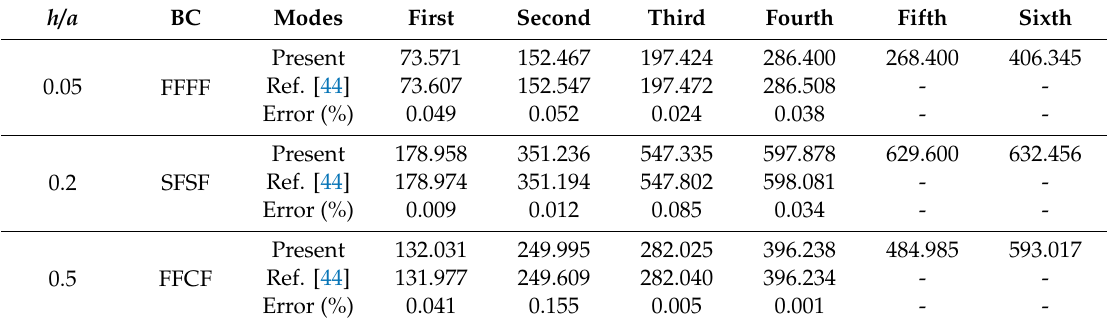
Table 3. First six natural frequencies (Hz) of angle-ply (45 ◦ / − 45 ◦ / 45 ◦ / − 45 ◦ ) laminated square plate with di ff erent thickness-length ratios and di ff erent boundary